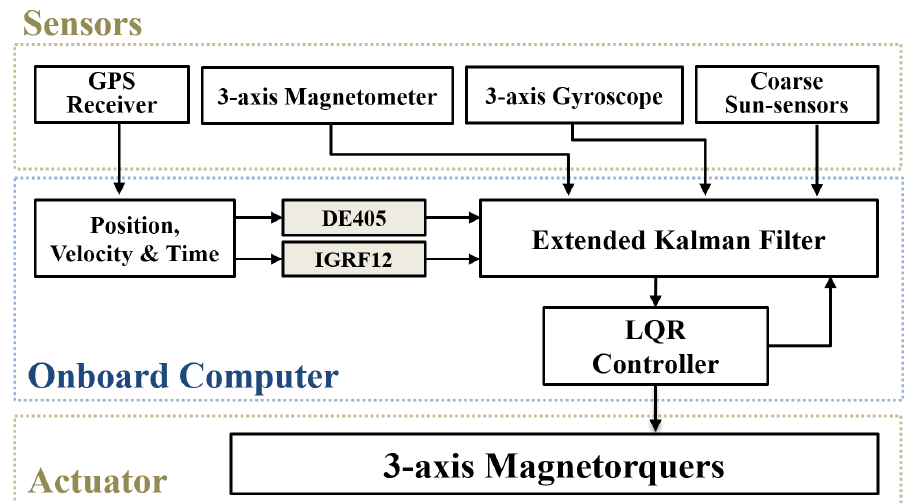
Figure 3. Block diagram of an linear quadratic Gaussian (LQG)-based attitude system. The image was reproduced with permission from [20].